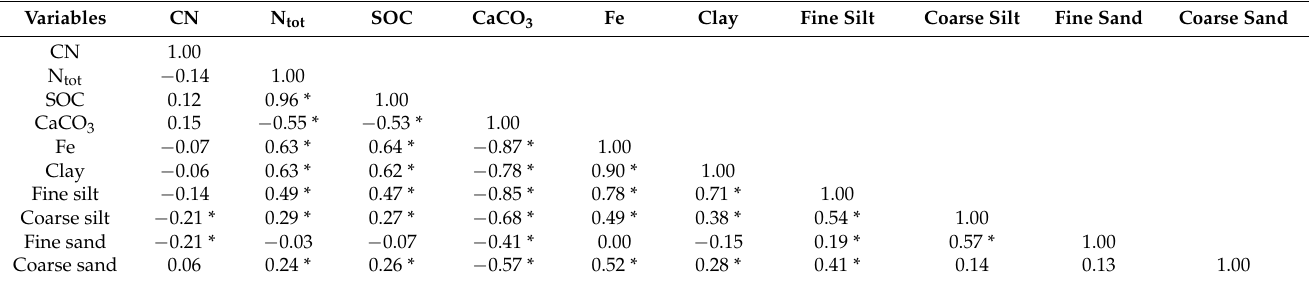
Table 4. Pearson correlation table of the common soil properties of all horizons (146